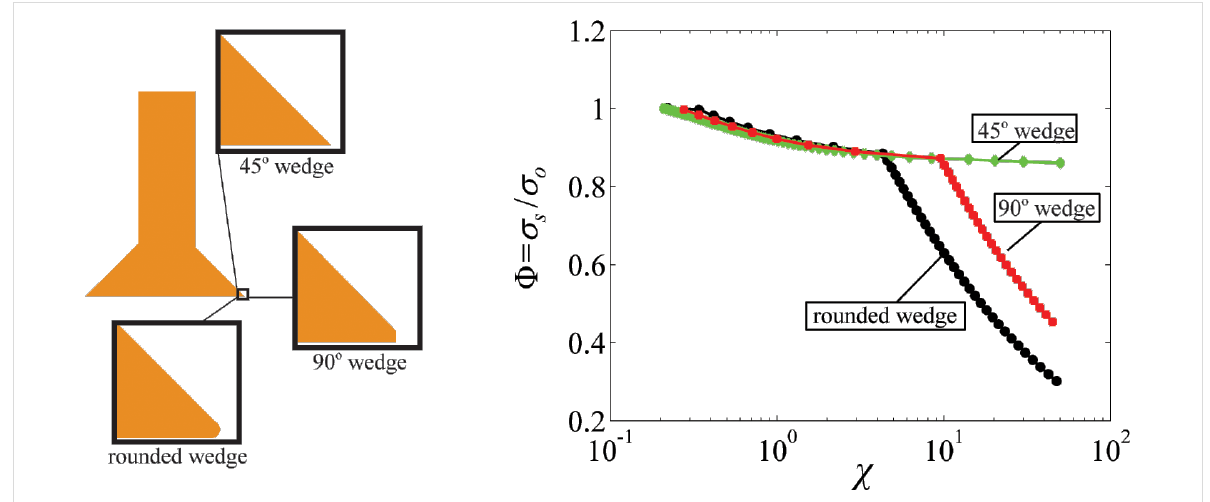
argument suggests that while fibers with small diameters and high elastic modulus (large χ ) favor wedge-angle independence, the dependence of pull-off stress to the wedge angle is signifi- cant for high strength interfaces (small χ ). This is assuming that the critical separation distance is in the order of 1 nm and some- what constant for van der Waals